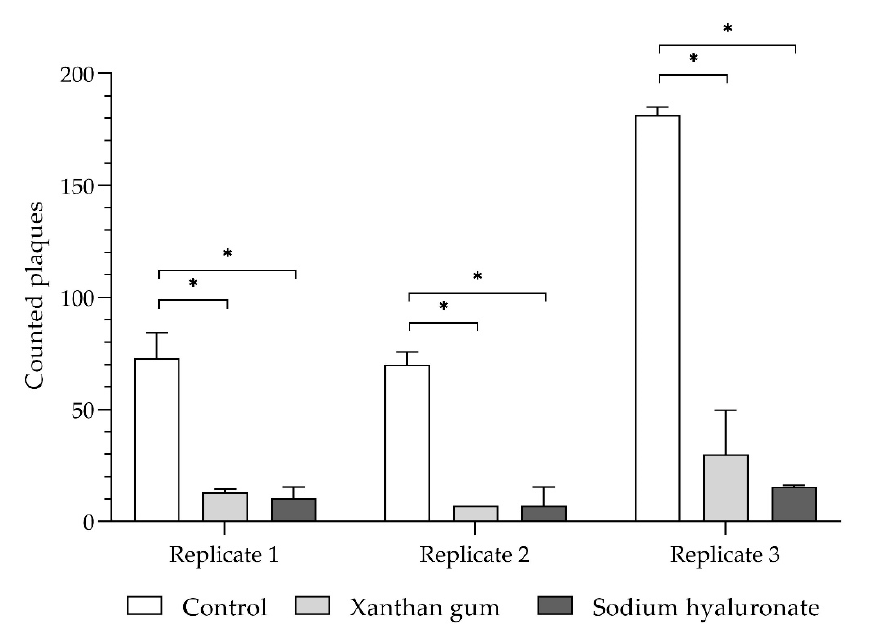
Figure 8. Results of the preventive plaque assa—Counted plaques on H1-HeLa cell monolayers of the untreated control (white) and cells treated with 0.35% xanthan gum (light grey) or 0.65% sodium hyaluronate (dark grey), mean ± standard deviation of the independent test runs with two repetitions, * p ≤ 0.05.